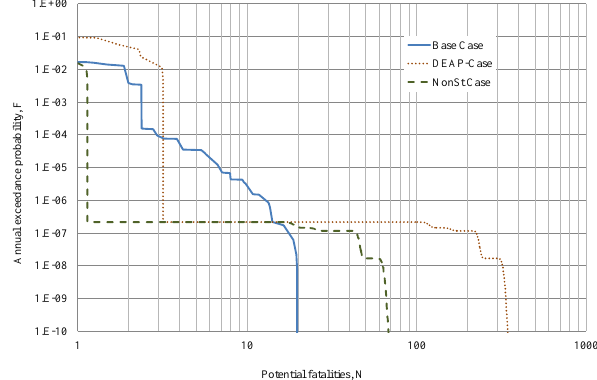
Fig. 15. FN-curves for all analyzed